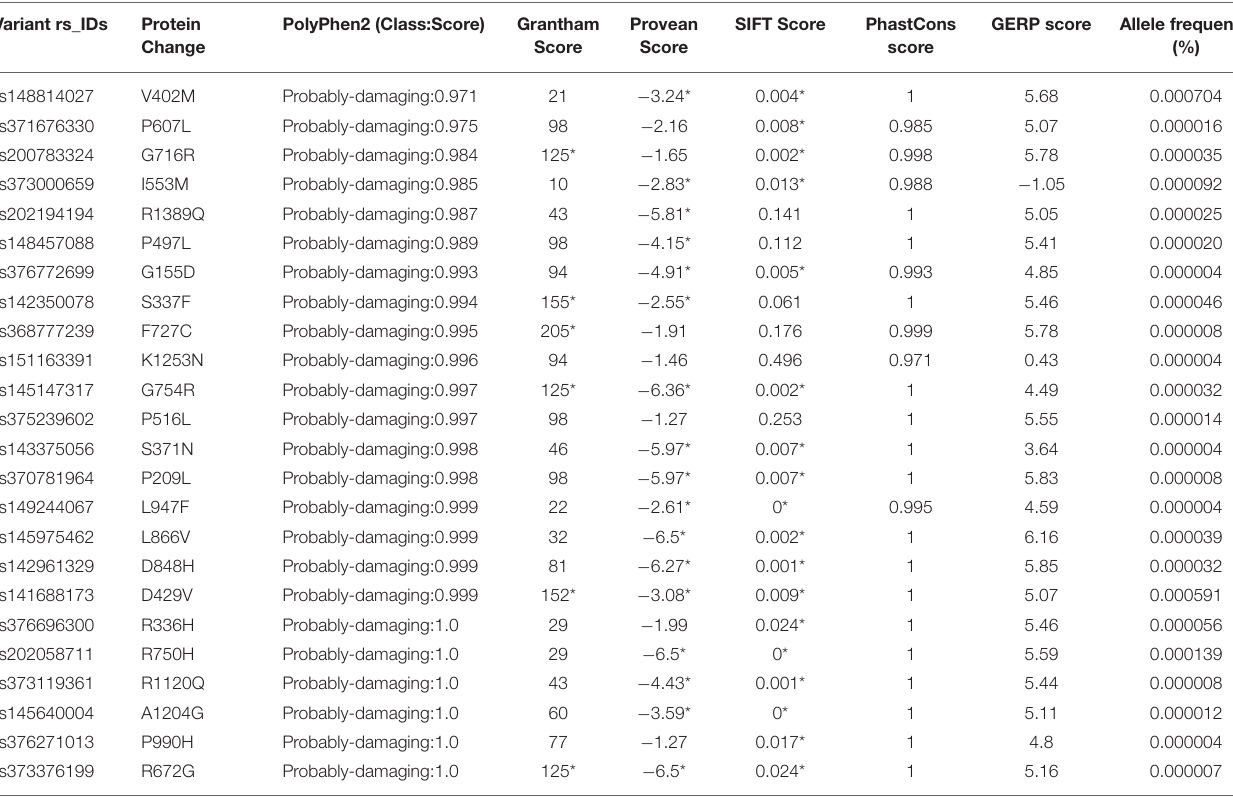
TABLE 1 | Novel potentially damaging NUP155 variants.